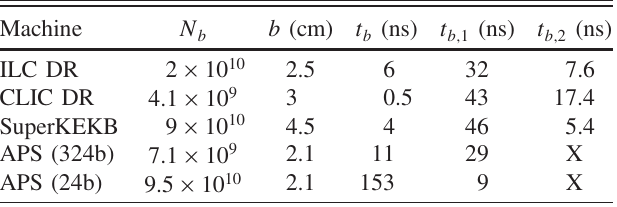
TABLE II. Resonant bunch spacings ( t b; 1 , t b; 2 ) compared to operational spacing ( t b ) for different